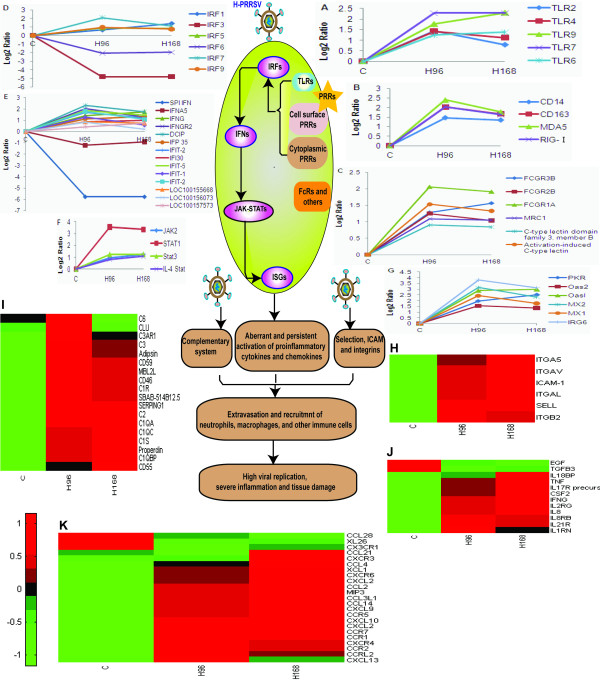
Induction of innate immune responses in pigs infected with H-PRRSV. PAMPs in H-PRRSV viral proteins and nucleic acids are recognized by PRRs that include TLRs (A), cell surface and cytoplasmic PRRs (B), Fc and other receptors (C). After binding to H-PRRSV viral PAMPs, PRRs initiate intracellular signaling cascades that activate transcription factors including IRFs (D) and STATs (F), which in turn induce the expression of IFNγ but not SPIIFNs (E), ISGs (G), pro-inflammatory cytokines and receptors (J), chemokines and receptors (K). Simultaneously, H-PRRSV infection activated complement proteins (I), selectin ligands, adhesion molecules and integrins (H). These recruit immune cells to sites of infection, resulting in severe inflammation and tissue damage. Figure 1H-K represent the heat maps of those DE genes selected. Genes shown in red were up-regulated and those shown in green were down-regulated in infected pigs relative to C pigs (See Additional file 2 for full gene names).